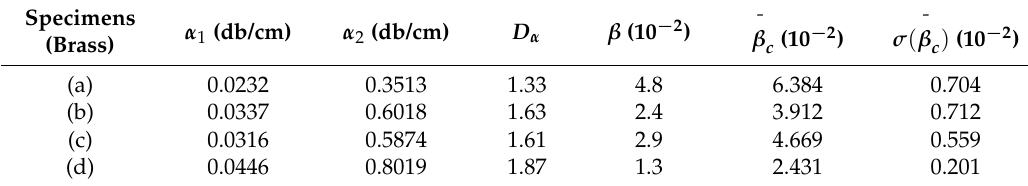
Table 4. Experimental results of ultrasonic testing in brass